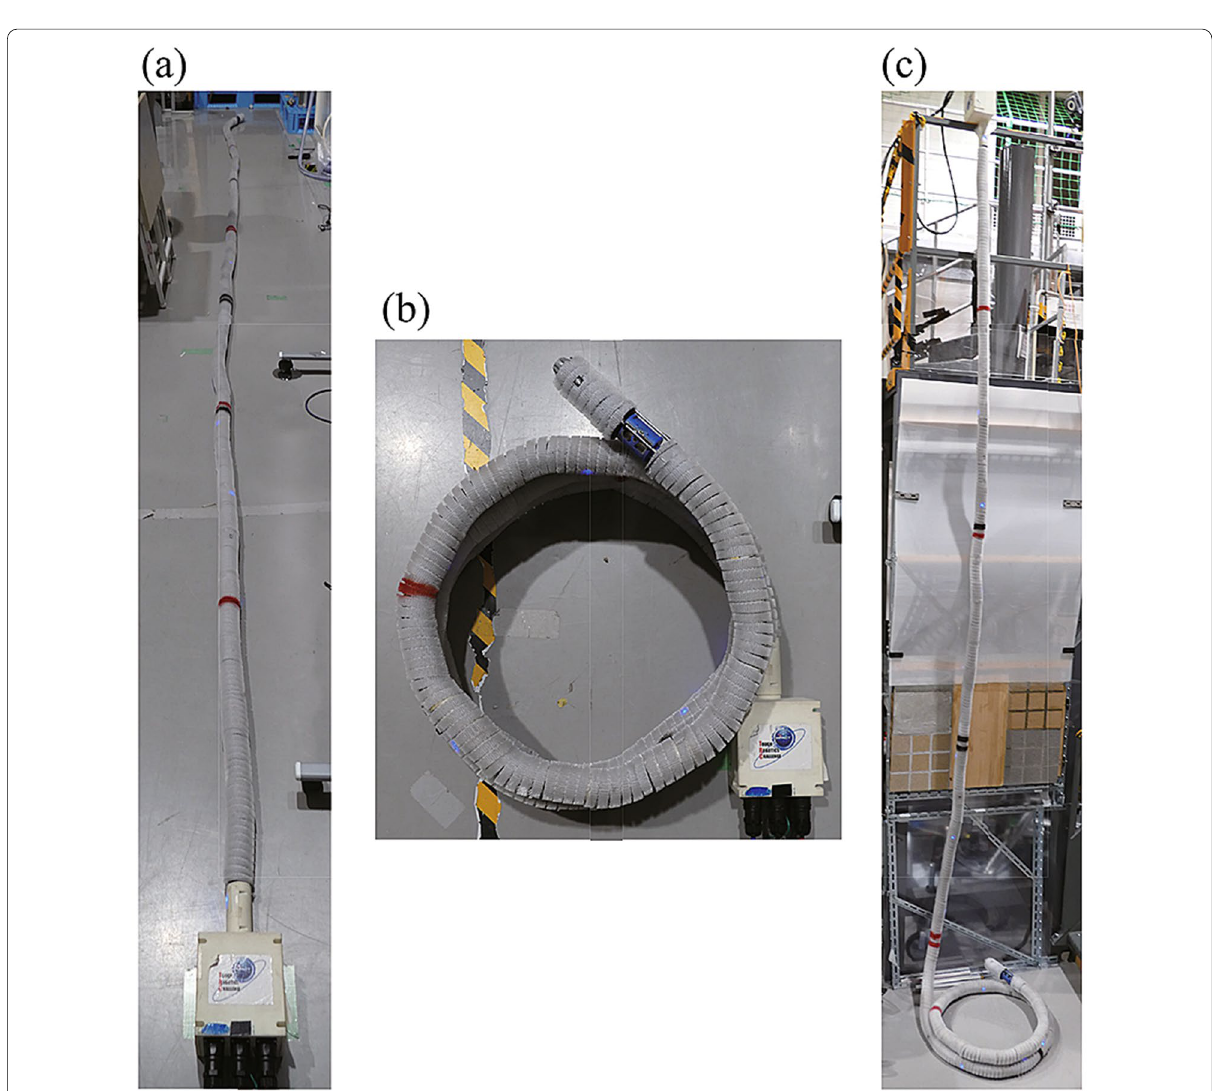
Fig. 9 Photos of the three different shapes of the robot. a Shape stretched as straight as possible and placed on the ground. b Shape wound with a minimum bend radius of approximately 250 mm. c Shape created by hanging the robot from 4 m above the ground and wrapping the remaining 3 m with a radius of about 250